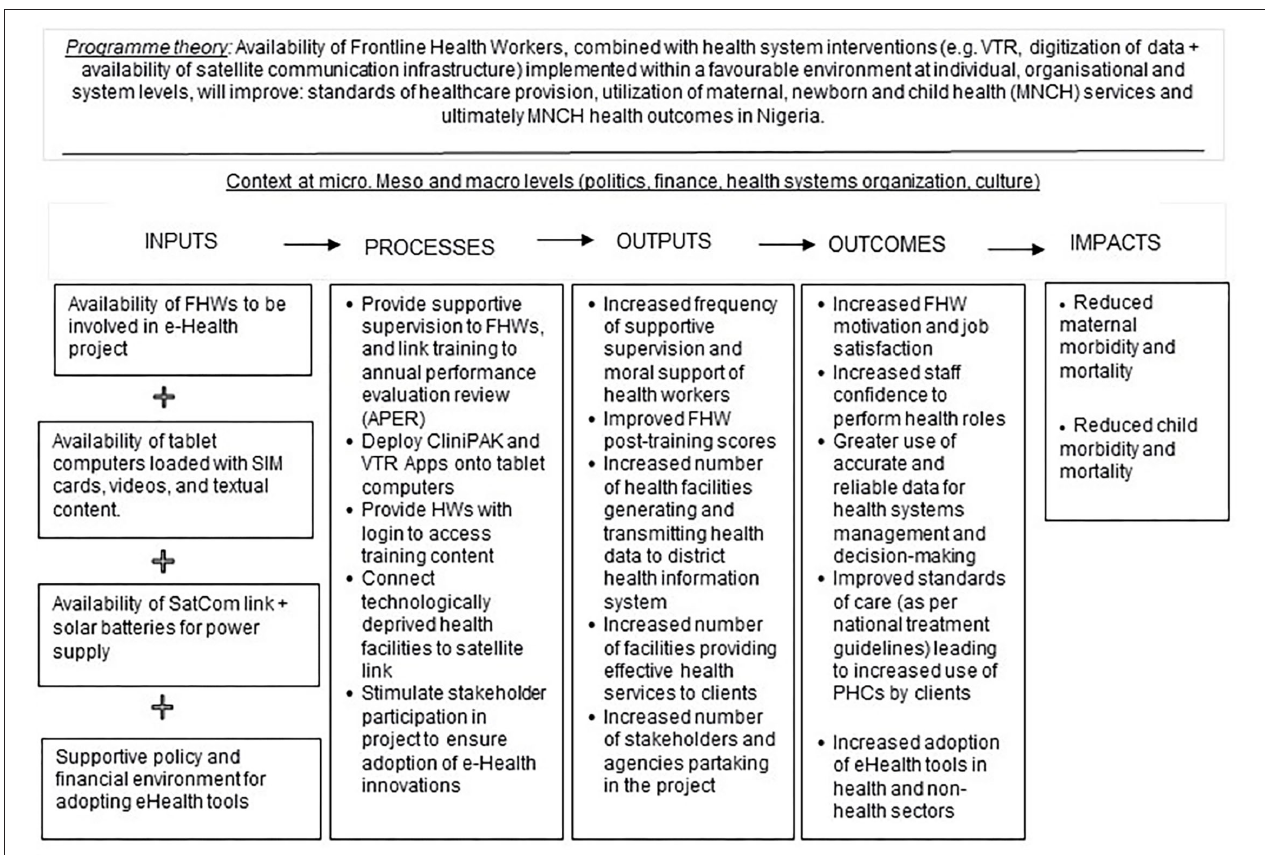
FIGURE 1 | Theory of change (ToC) model for eHealth project in Nigeria.